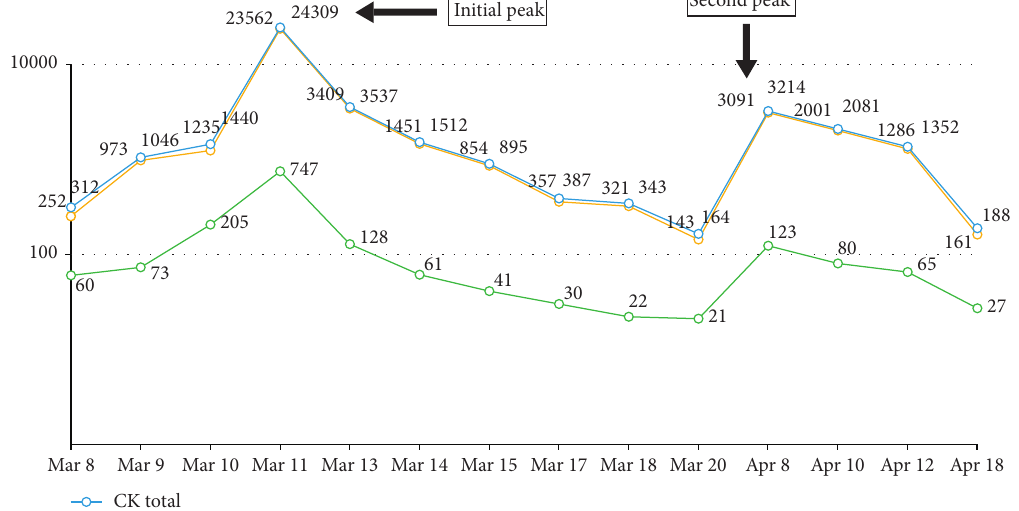
Figure 1: Creatine phosphokinase (CPK)